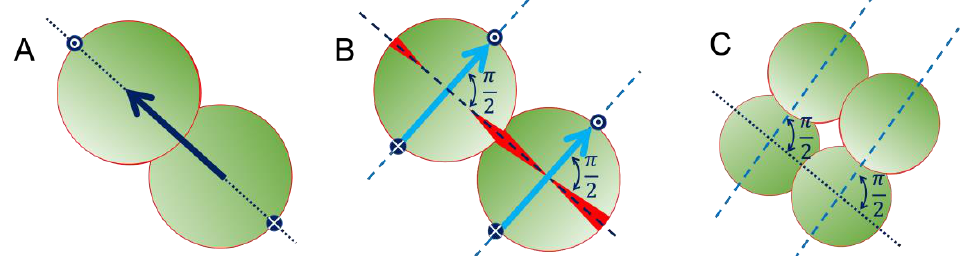
Figure 1. Schematic representation of the spatial orientation of subsequent cell-division cycles for Staphylococcus spp., showing that the new septa (in red) are formed in the line containing the direction of the previous division, indicated by a dark blue arrow in ( A ), and determining the direction of the next division cycle in the orthogonal plane ( B , C ). This process is regulated by the positioning of specific proteins at the cell envelope, represented by blue dots.